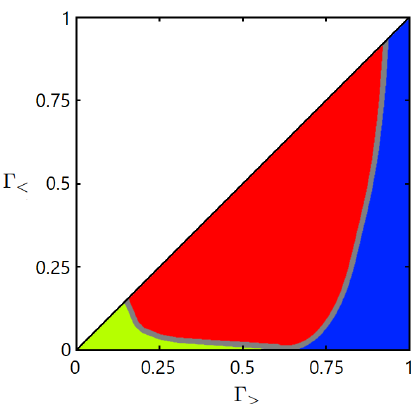
Figure 13: Phase diagram of a priority rule intersection with two major priority fluxes, Γ ( 4 ) = Γ ( 5 ) = Γ > , and a minor secondary flux, Γ ( 6 ) = Γ < . At each point we plot which priority rule, between the priority intersection one (yellow region), the perfect roundabout (red region) (both with β = 1) and the traffic-light (blue re- gion), exhibits the higher current across the system. We assume that the main roads ( (cid:96) = 4,5) accommodate most of the flow, setting α ( 1 ) = α ( 2 ) = 0.75. The flux through the secondary road is taken symmetric, setting α ( 3 ) = 0.5. The other parameters are = 0.1, Γ ( (cid:96) ) = 1, γ ( (cid:96) ) = 3. For the traffic-light case, we set T = 2 and t ( (cid:96) ) = 1, Γ C j = 0.75 T t 1